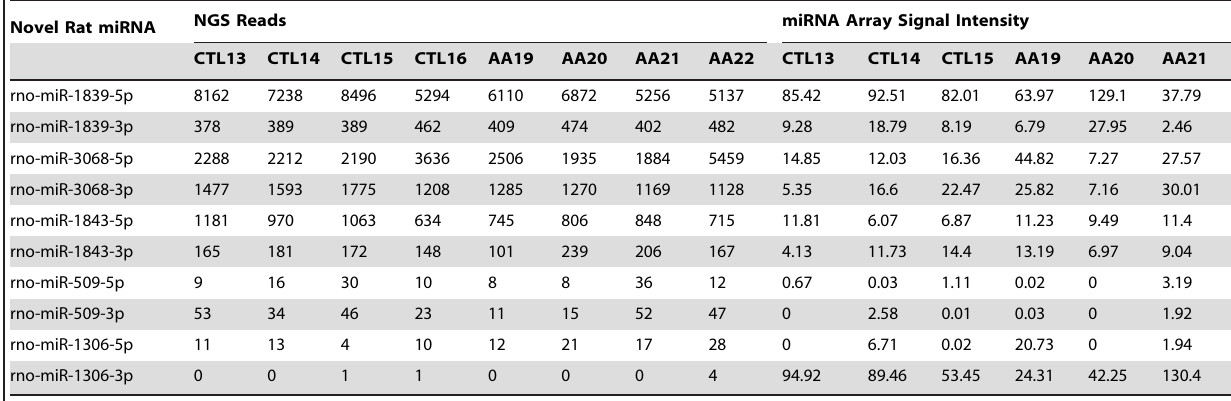
Novel Rat miRNA NGS Reads